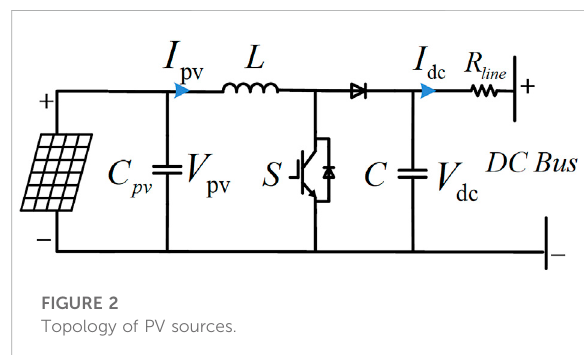
FIGURE 2 Topology of PV